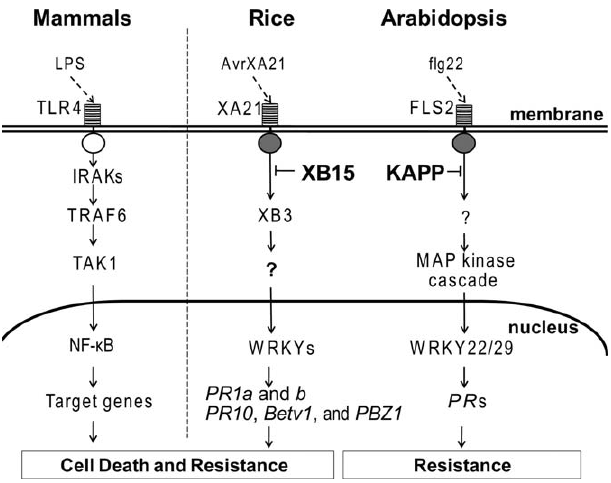
Figure 10. Comparison of Mammal, Arabidopsis , and Rice PRR-Mediated Signaling The LRR domain of TLR4 recognizes lipopolysaccharide signal (LPS) and transduces the signal across the cell membrane [91]. An adaptor molecule myeloid differentiation factor 88 (MyD88) associated with TLR4 recruits the non-RD serine/threonine kinase, IRAK1, which associates with tumor necrosis factor receptor associated factor 6 (TRAF6) in cytoplasm [102]. TRAF6 forms a complex with TAK1 [93] in which the kinase activity of, TAK1 mediates downstream events, such as inhibitor of j kinase complex and NF- j B [5,95]. In Arabidopsis , flg22 binds to FLS2, which transduces the pathogen signal through its cytoplasmic non-RD kinase domain, and activates MAPK cascade [15]. Several WRKY transcription factors acting downstream of MAPK cascade to induce defense-related genes including PR genes [97]. KAPP, a PP2C, blocks the activated FLS signaling and attenuates the downstream innate immune response [33]. In rice, AvrXA21 binding to XA21 activates its cytoplasmic non-RD kinase [18,20]. XA21 trans- phosphorylates proteins such as XB3, which are required for the defense response [42]. In the nucleus, WRKY transcription factors activate defense-related genes such as PR1 and PR10 of XA21 signaling pathway. Recruitment of XB15 to Ser697 in the XA21 JM domain and subsequent dephosphorylation of phosphorylated residue(s) attenuates XA21